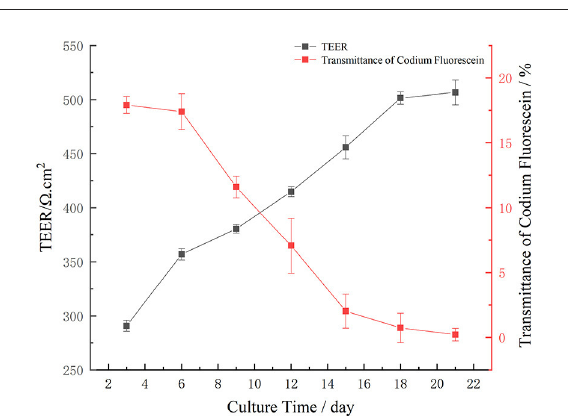
FIGURE3 Trend of monolayer transmembrane resistance of Caco-2 cell during different culture periods, and transmittance of fluorescein sodium in different culture time: Transmittance of sodium fluorescein from AP side to BL